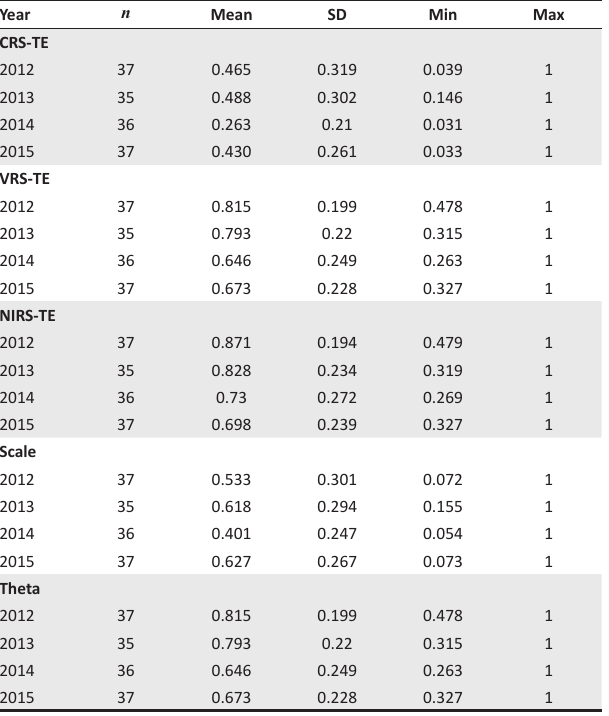
TABLE 4: Summary statistics of the different measures of efficiency.